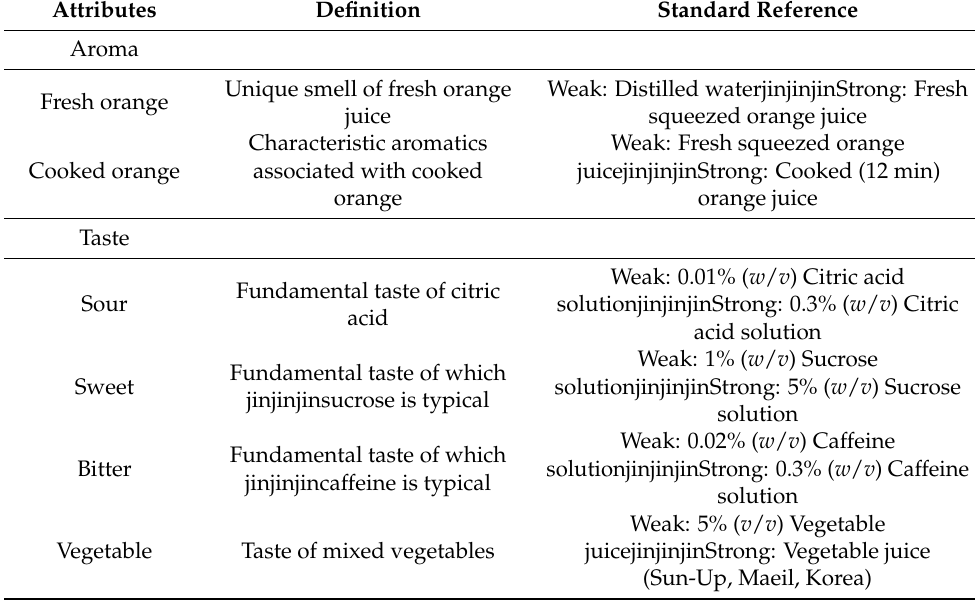
Table 1. Attributes used for the sensory evaluation of orange juice by descriptive